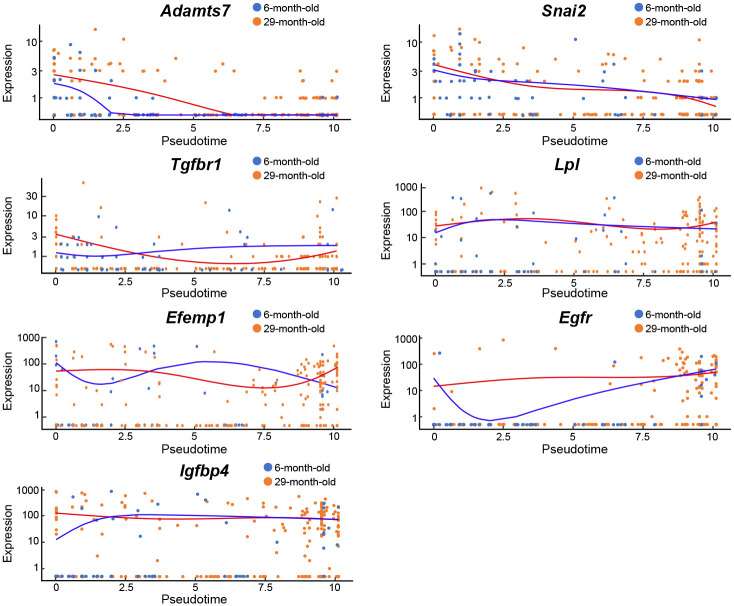
Age-associated changes in gene expression patterns.Kinetic plots showing the expression of Adamts7, Snai2, Tgfbr1, Lpl, Efemp1, Egfr, and Igfbp4 over pseudotime are shown. The orange line indicates young cells (cell number, n = 61), and the blue line indicates old cells (cell number, n = 209).